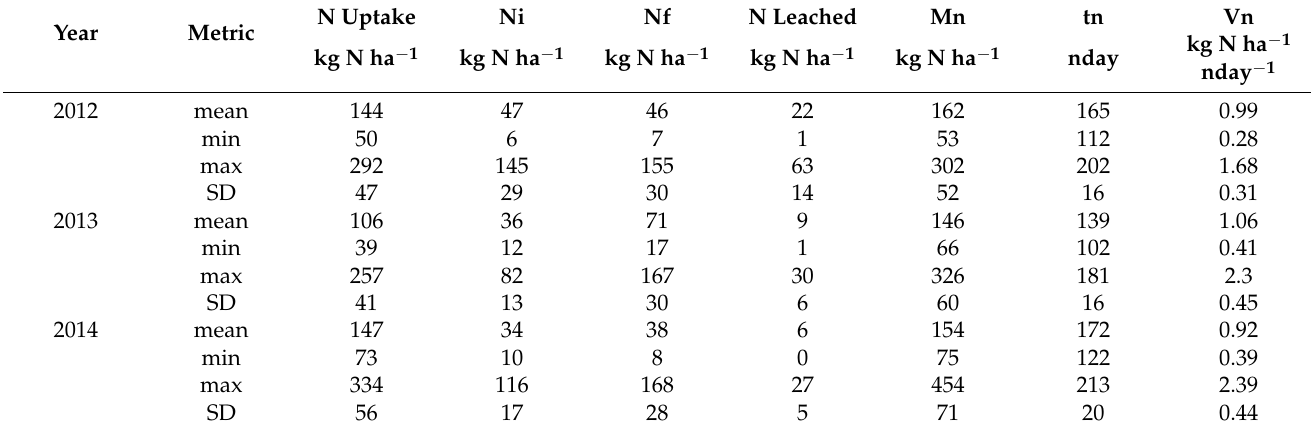
Figure 4. Boxplots of ( a ) soil organic nitrogen (SON), ( b ) extractable organic nitrogen (EON), and ( c ) soil microbial biomass (SMB) for all 137 fields and for the 67 fields selected from the network. Whiskers extend to 1.5 times the interquartile range. Table 2. Mean, minimum, maximum, and standard deviation (SD) of the mass-balance components and nitrogen (N) mineralization rates for the 67 fields selected. N uptake is N taken up by maize plants, Ni and Nf are, respectively, the initial and final amount of mineral N in the soil profile (0–90 cm), N leached is N leached out of the soil profile predicted by the STICS crop model, Mn is net N mineralization, ndays is normalized time between initial and final N measurements, and Vn is normalized N mineralization